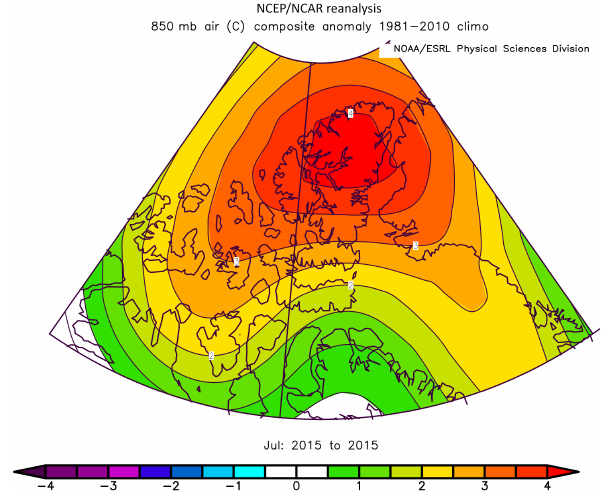
Figure 6. Summer (JJA) 2013 air temperature anomalies at the 850hPa level from the NCEP/NCAR reanalysis relative to a 1981– 2010 baseline.